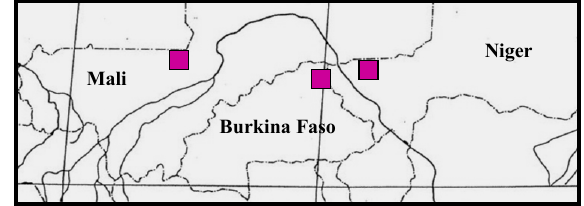
Figure 2. Position of research sites in Mali, Burkina Faso, and